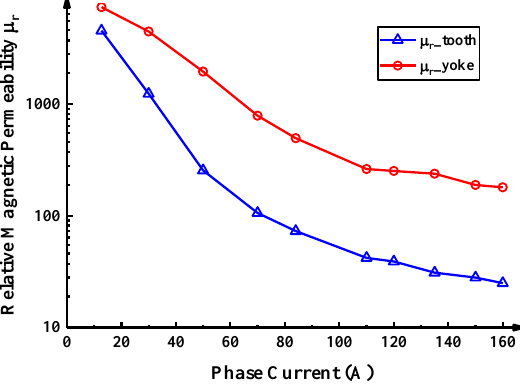
Figure 13. The relative permeability change at different current.